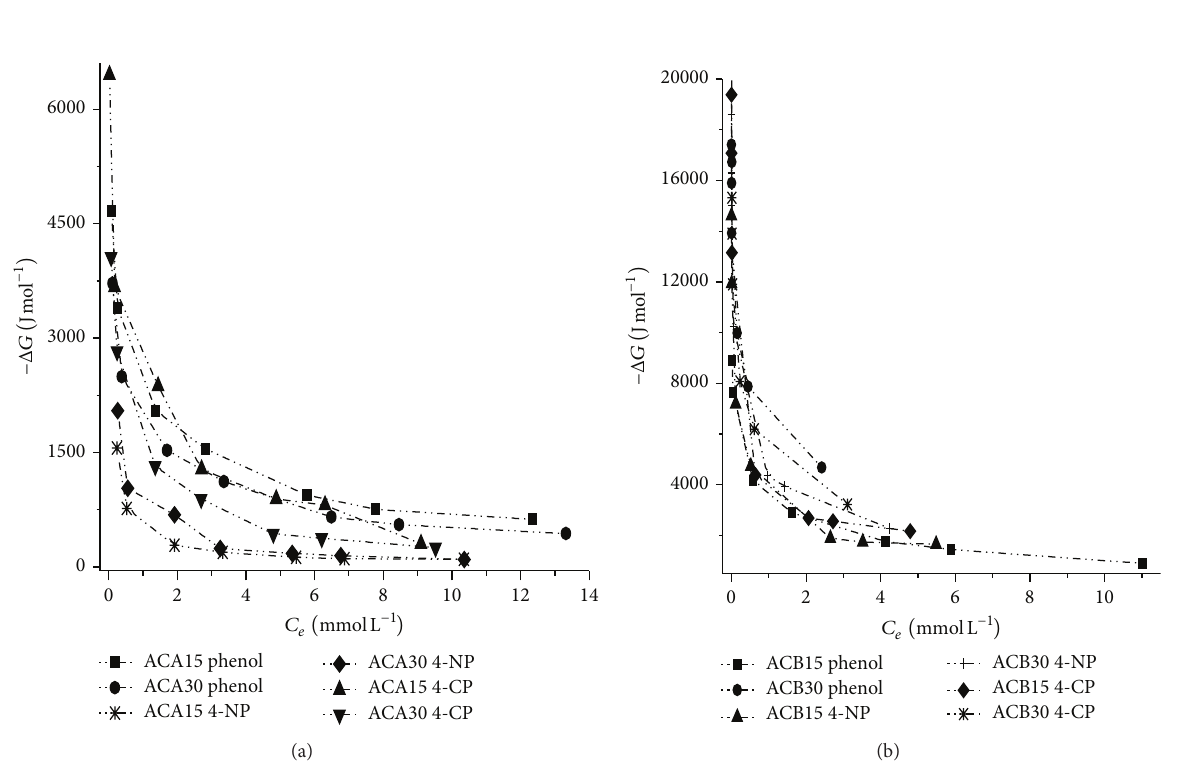
Figure 8: Change in free energy in function of equilibrium concentration of phenols on ACs at 20 ∘ C.